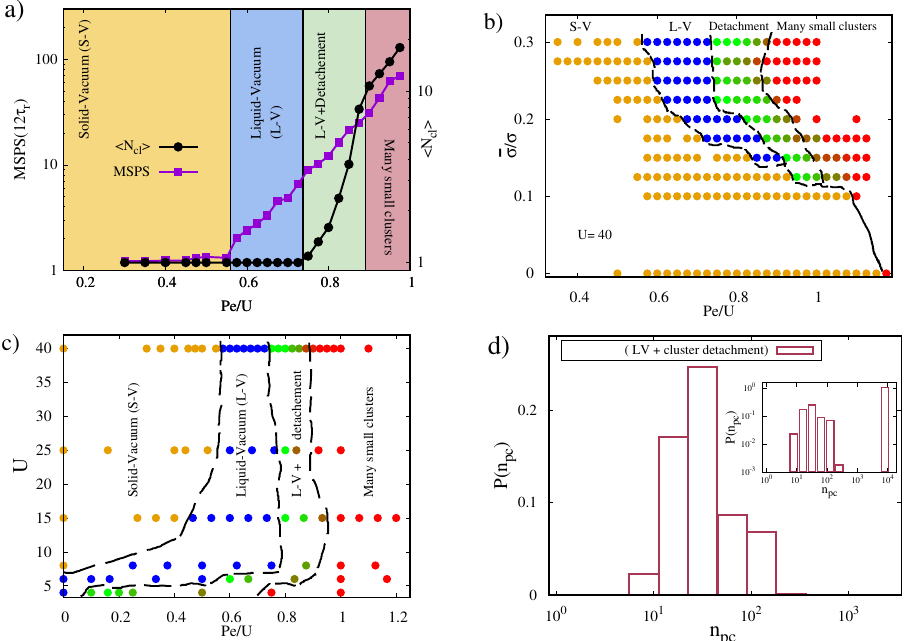
Fig. 2 Quanti fi cation of phase behavior. a “ MSPS ” (left axis) and N cl (right axis) as a function of Pe/ U , for fi xed U = 40 with increasing activity. MSPS( t ) is calculated at time separation t = 12 τ r . The orange area indicates S − V coexistence, the blue area L − V coexistence, the green area L − V coexistence with small detached cell clusters in the gas phase, and the red area a homogeneous phase of many small clusters. Results are for (cid:1) σ = σ ¼ 0 : 3. b Phase diagram as a function of the potential width (cid:1) σ for fi xed U = 40. Note that the potential width (cid:1) σ needs to be suf fi ciently large, with (cid:1) σ = σ ≥ 0 : 15, to allow liquid-vacuum coexistence c Phase diagram various U as a function of rescaled Peclet number, Pe/ U , for fi xed (cid:1) σ = σ ¼ 0 : 3. d Cluster-size distribution of detached clusters, of size n pc , at (cid:1) σ = σ ¼ 0 : 3, U = 40, and Pe = 32. Inset: Same data in log – log representations, which also includes the parent colony along with the detached